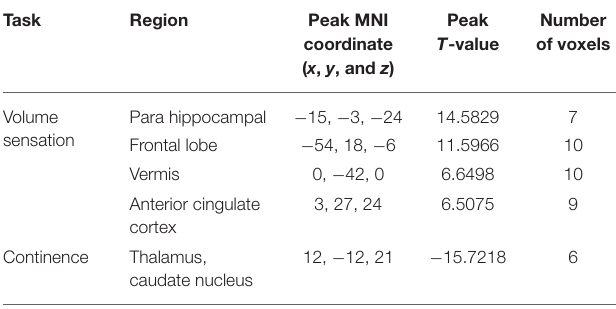
TABLE 2 | Regions responding to neobladder volume sensation and neobladder voluntary